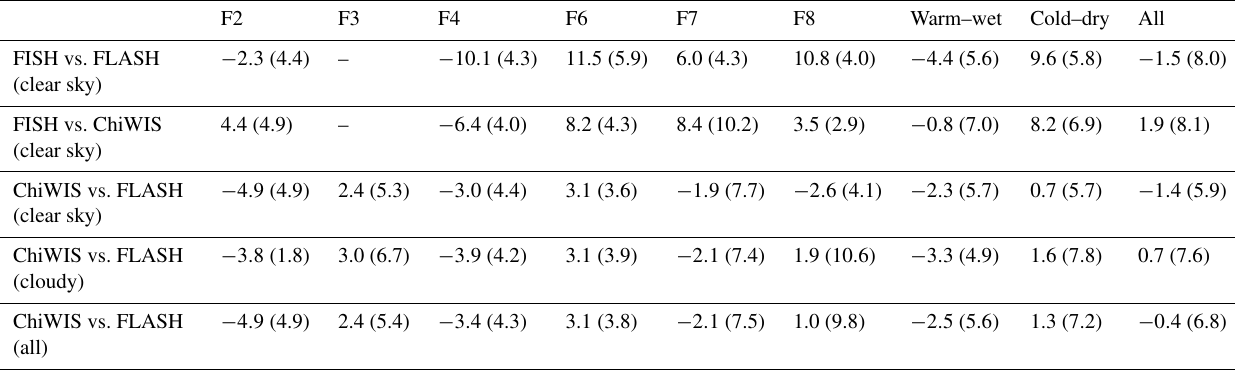
(cid:104)(cid:16) x − y (cid:17) (cid:105) × 100% and σ (cid:49) = std y